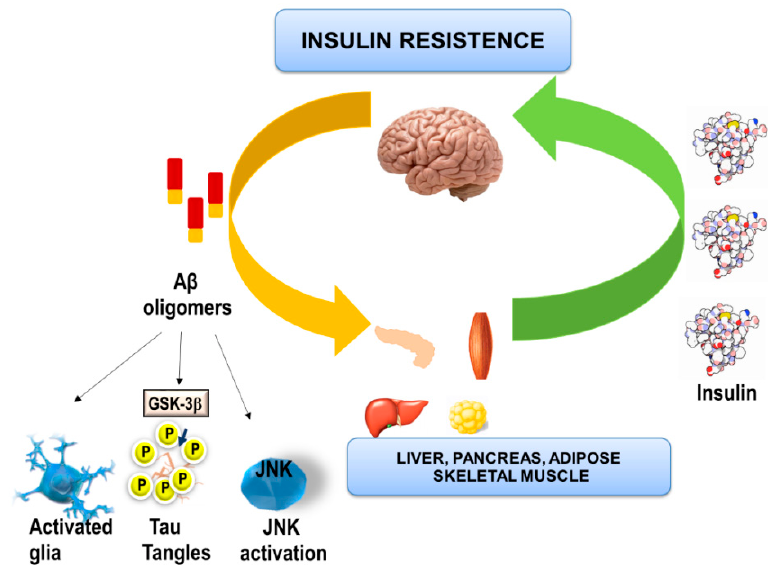
Figure 2. A β acting on the hypothalamus can dysregulate energy homeostasis in the human organism through a neuroinflammatory process. Furthermore, in the hippocampus, activation of glial reactivity could increase cytokine levels (such as TNF- α ), activating c-Jun N-terminal Kinase and inducing IR resistance and TAU phosphorylation. Likewise, brain generated A β could accumulate in peripheral tissues such as the pancreas and skeletal muscle, favouring the appearance of T2DM.